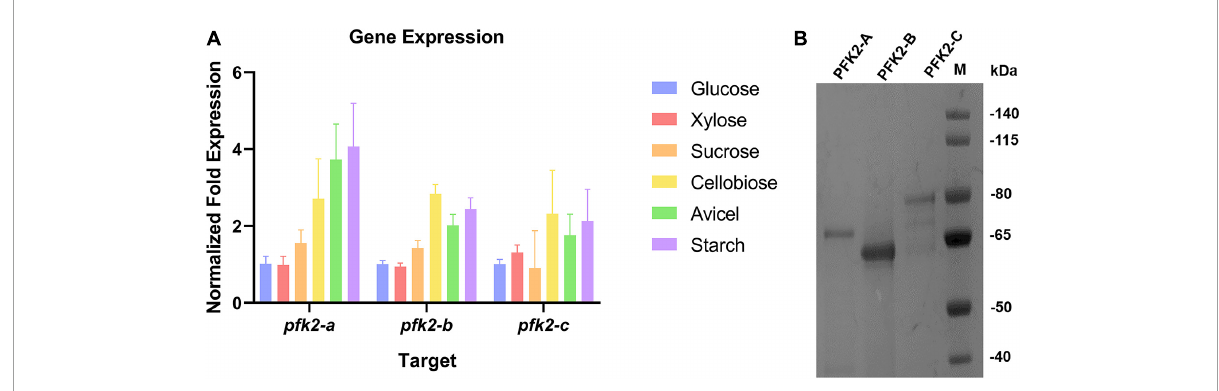
FIGURE1 The qRT-PCR analysis of gene expression and protein purification of PFK2/FBPase-2 in Myceliophthora thermophila . (A) Expression levels of the three coding genes in M. thermophila after 2 days of culture in media containing glucose, xylose, sucrose, cellobiose, Avicel and starch; actin was used as the reference gene. (B) Coomassie blue staining of purified PFK2-A/B/C proteins following SDS-PAGE. PFK2-A/B/C were expressed in Escherichia coli and purified by Ni chelate affinity chromatography. Molecular weight markers in kDa are shown at the